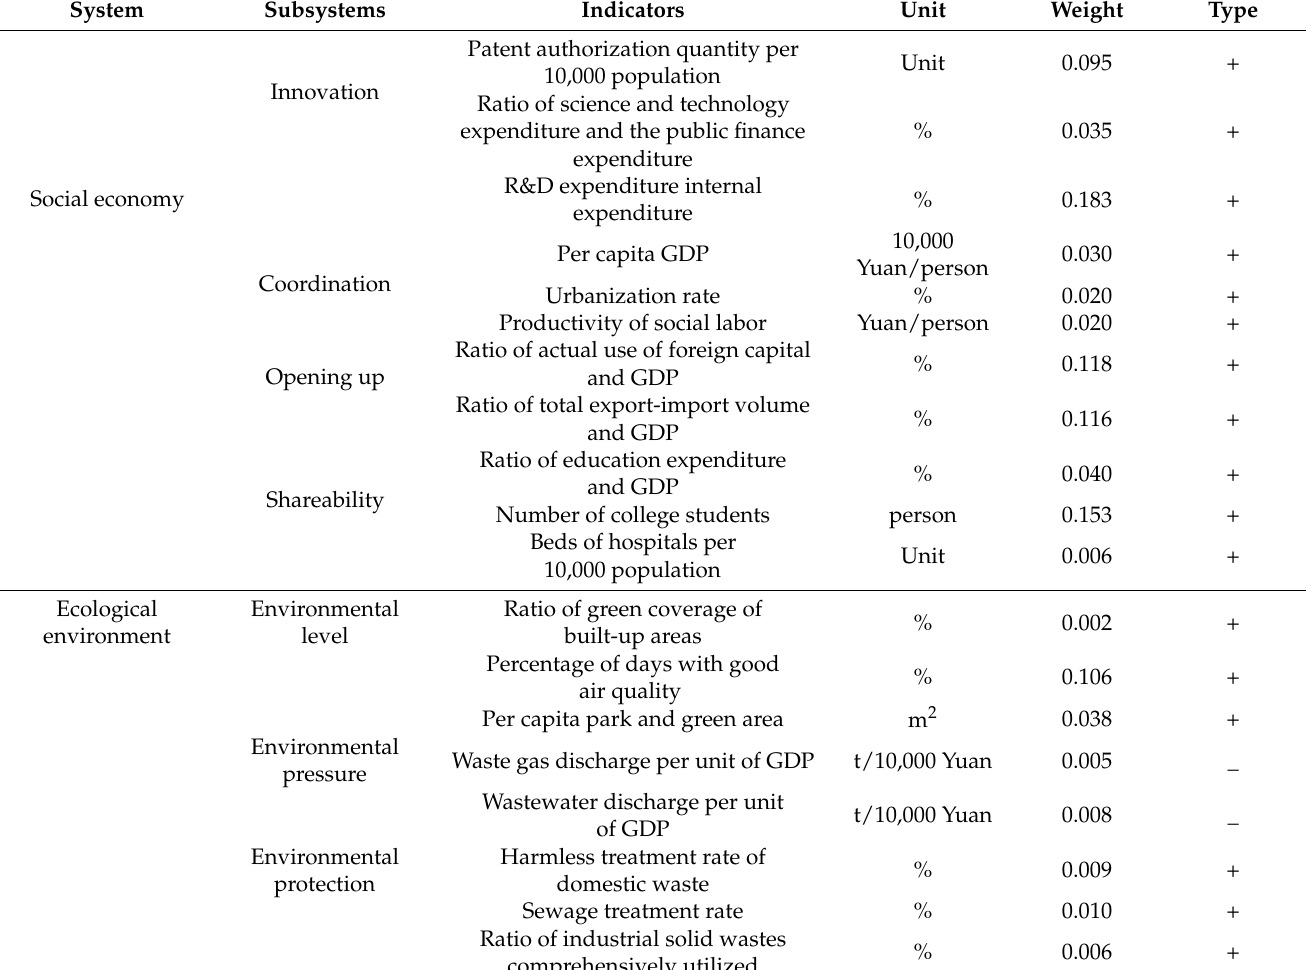
Table 1. Index system and weight calculation